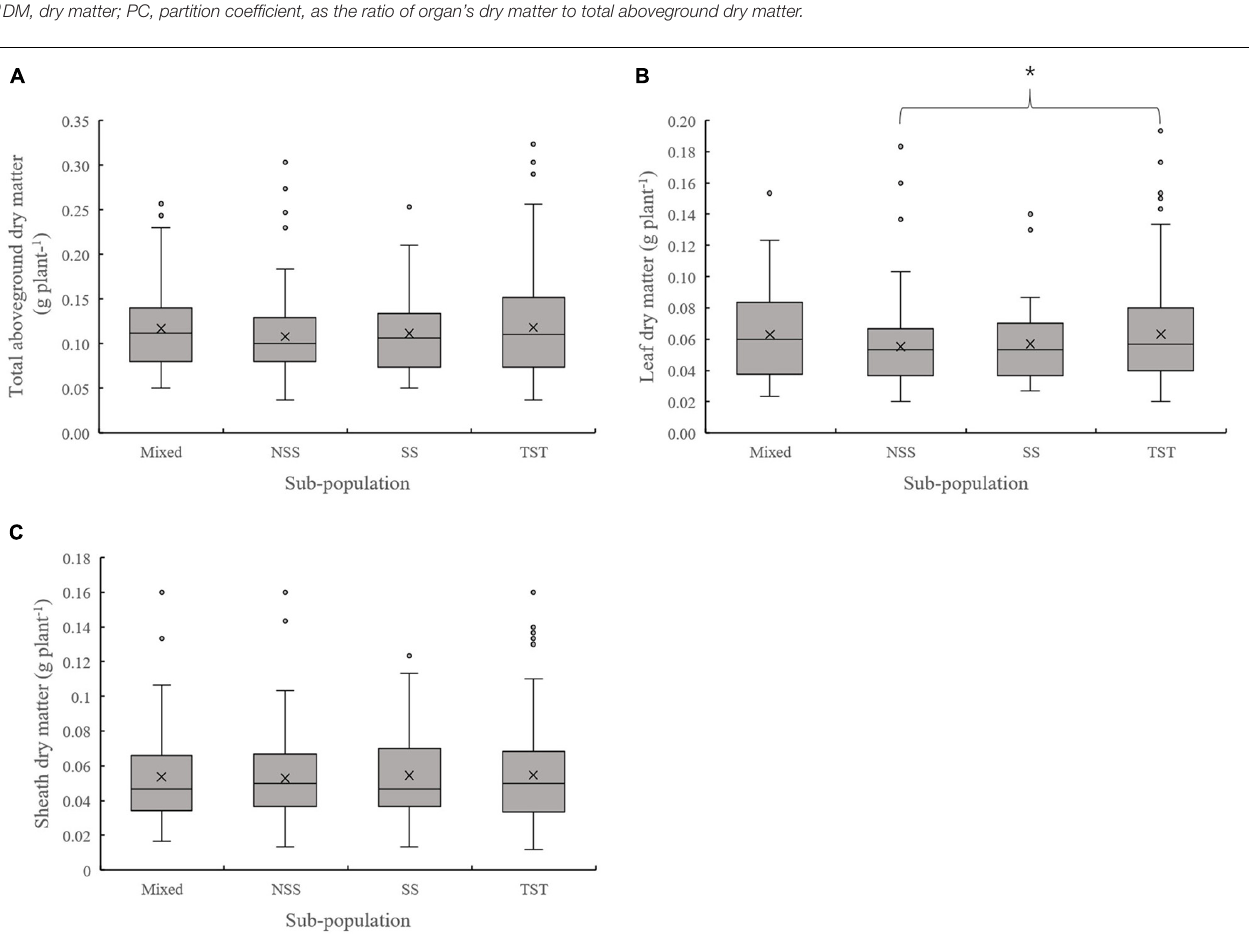
partition coefficient calculated from this set of data in